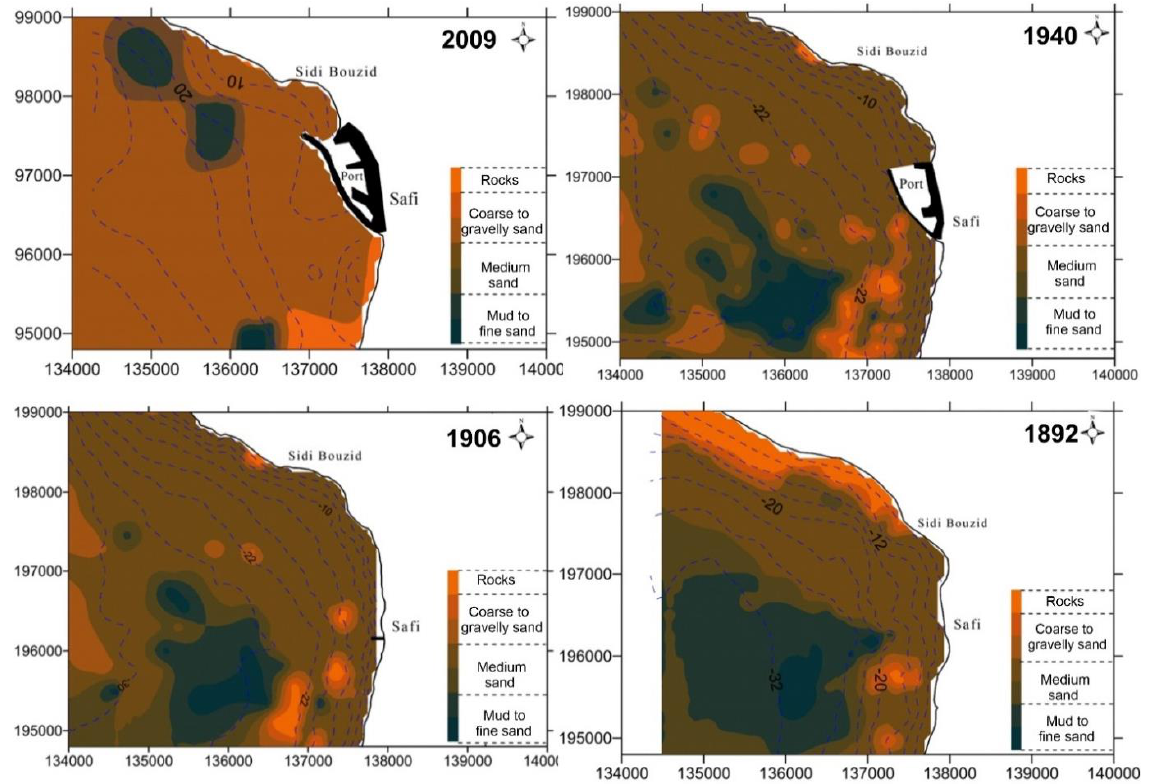
Figure 3. Distribution of sedimentary facies in Safi Bay in 1892, 1906, 1940 and 2009, respectively.